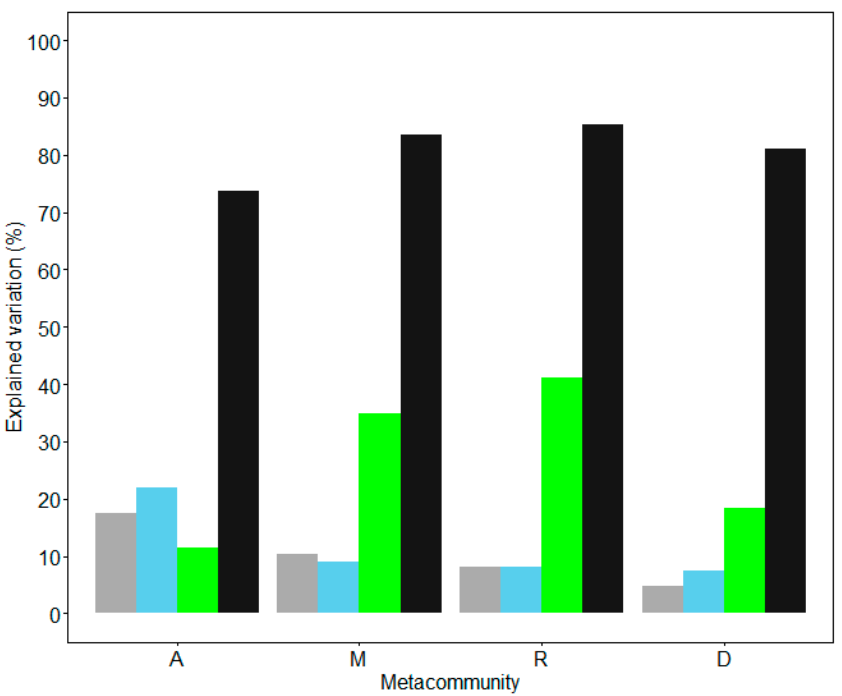
Figure 4. Variations of bird species composition in metacommunity A (localities in the whole study area), metacommunity M (localities in the mountain landscape), metacommunity R (localities in the riparian landscape) and metacommunity D (localities in the desert landscape) explained by only environment (grey), space (blue) or connectivity (green) predictor, and the maximum variation explained by all of the three predictors (black) at longest dispersal distances (i.e., largest α values). All of the models showed p < 0.01 by the Monte Carlo permutation test.